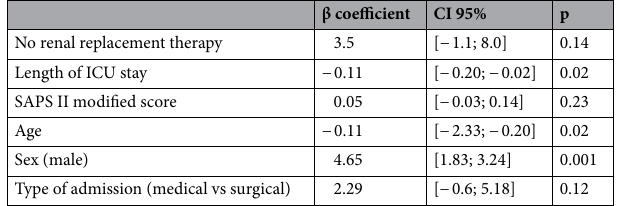
Table 2. Multiple linear model associated to FACIT-F. For each increase of 1 unit of the variable, there is an increase of the β coefficient. SAPS Simplified Acute Physiology Score, ICU Intensive care unit.